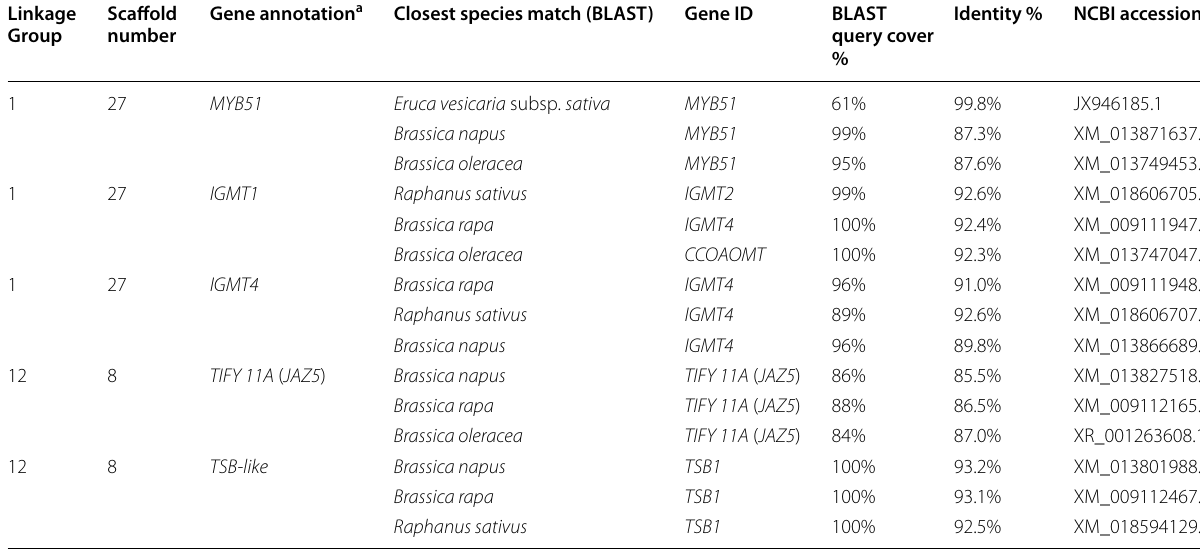
Table 3 Genes identified underlying 4-methoxyglucobrassicin QTL with the closest match NCBI accession sequences from related species